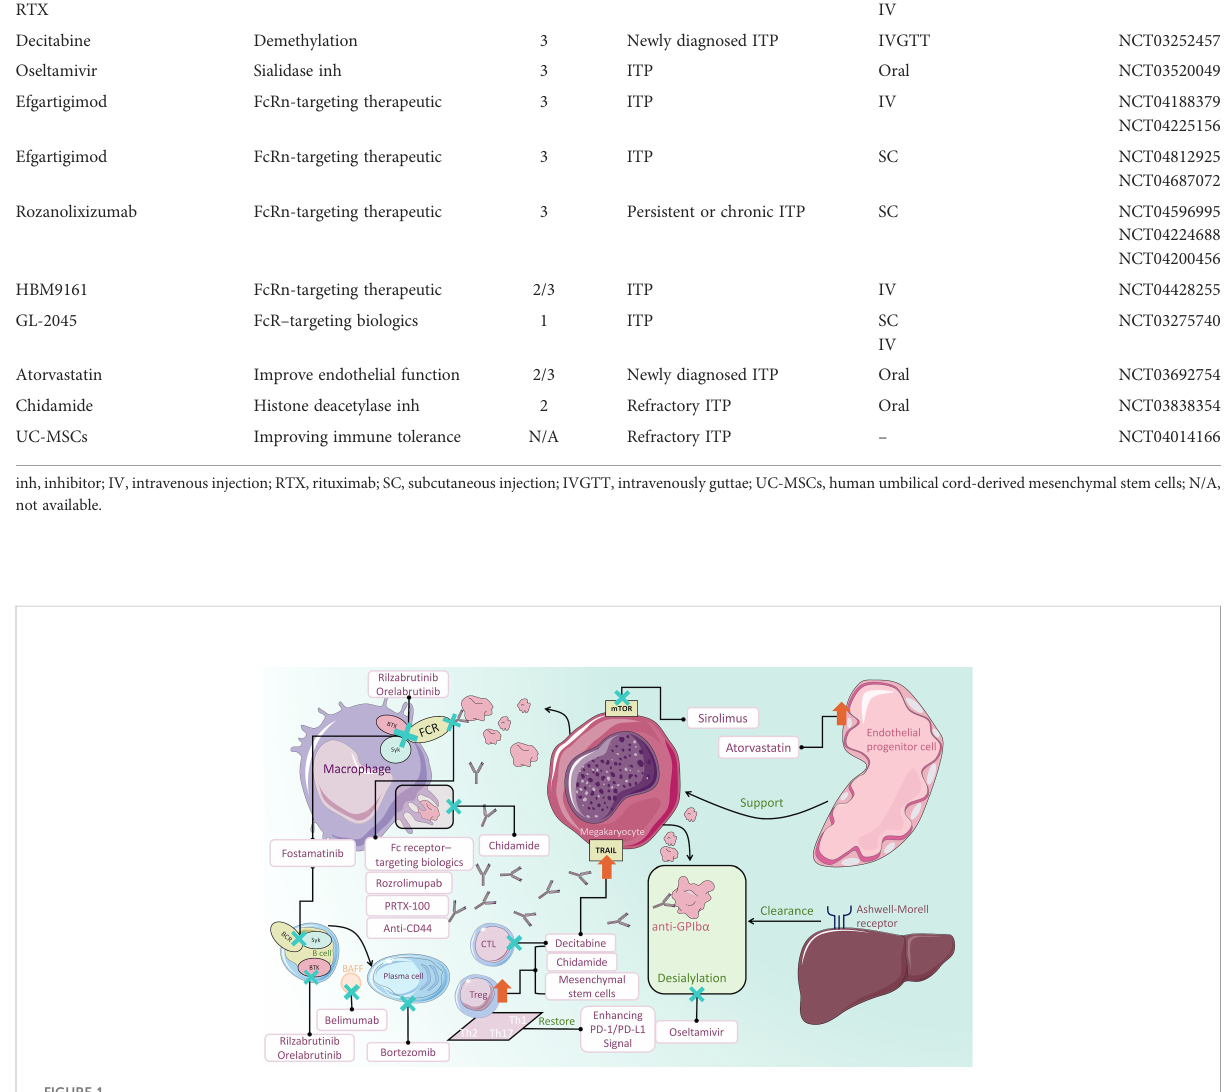
FIGURE 1 Mechanisms of ITP medications. Fostamatinib impairs Syk-mediated phagocytosis of platelets. Rilzabrutinib and orelabrutinib block Fc g R signaling pathway transduction by inhibiting BTK. PRTX-100, Fc receptor-targeting biologics, rozrolimupab and anti-CD44 inhibit macrophage phagocytosis by blocking IgG binding to Fc receptors. Oseltamivir inhibits glycoprotein-induced desialylation, protecting platelets from clearance by hepatocyte Ashwell-Morell receptors. Sirolimus acts on mTOR on megakaryocytes to regulate autophagy. Decitabine not only promotes megakaryocyte maturation but also regulates Treg cells and CTLs. Enhancement of the PD-1/PD-L1 signaling pathway could restore the balance of Th cells. Chidamide increases the immunosuppressive functions of Treg cells and inhibits macrophage phagocytosis. Mesenchymal stem cells could upregulate Treg cells. Bortezomib stimulates apoptosis in LLPCs and short-lived plasma cells, thus decreasing antiplatelet antibodies. In the context of depleting B cells, adding Belimumab to block BAFF can reduce the number of splenic plasma cells. Atorvastatin improves endothelial progenitor cells function to promote megakaryopoietic